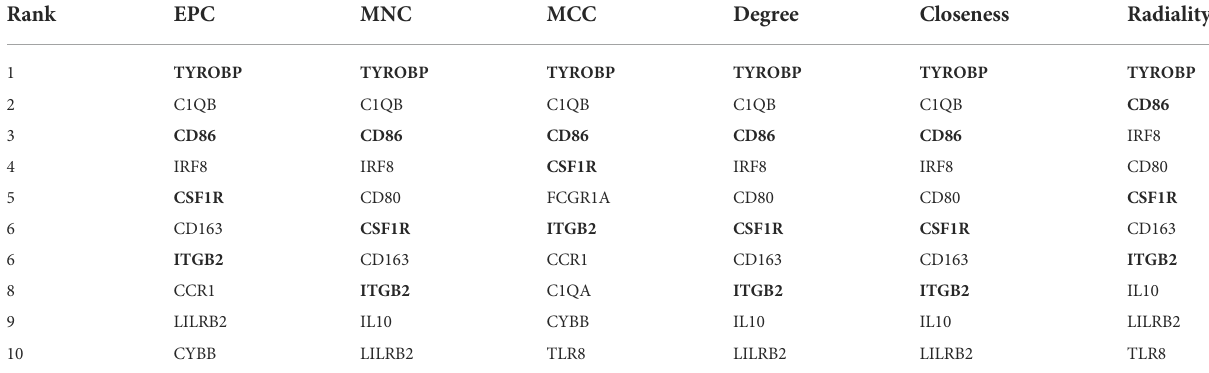
TABLE 2 Screening of hub genes using six algorithms in cytoHubba. The bold value represents Hub genes Rank EPC MNC MCC